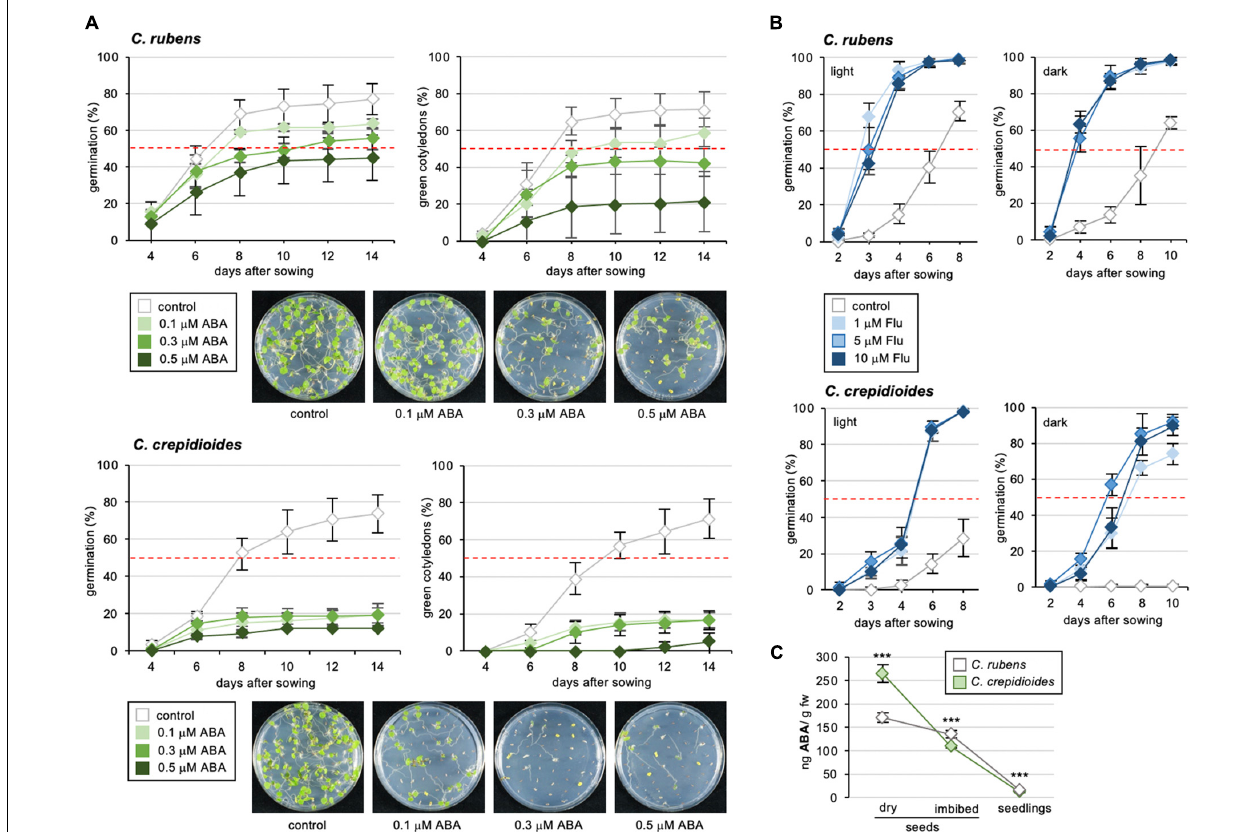
FIGURE 3 | Crassocephalum crepidioides is hypersensitive to ABA and Fluridone treatment during germination. (A) Response of C. rubens and C. crepidioides to externally applied ABA in terms of germination capacities and cotyledon greening. 50 seeds of each accession were plated on 1/2 MS medium without (control) or with 0. 1-, 0. 3-, or 0.5- µ M ABA and incubated in 16-h 30 µ mol m − 2 s − 1 white light/8-h dark cycles at a temperature of 25 ◦ C. Seed germination (left graph), was defined as radicle emergence from the seeds coat. Cotyledon greening (right graph) was defined as fully developed, green cotyledons. The means and SDs are shown. Photos of representative plates are shown below the graphs. (B) Response of C. rubens and C. crepidioides seeds to externally applied Flu during germination in the light and in the dark. 50 seeds of each accession were plated on 1/2 MS medium without (control) or with 1- µ M Flu, 5- µ M Flu, or 10- µ M Flu